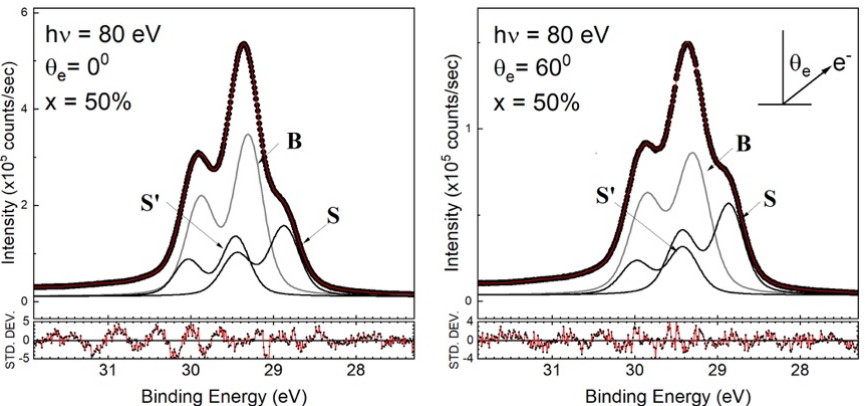
Figure 4. Fit to the Ge 3d core-level spectra with the 50% Ge content of Si 1 − x Ge x (001)-2 × 1. θ e is the emission angle with respect to the surface normal. Symbols S and S’ stand for Ge up-dimer and Ge down-dimer counterparts. Symbol B stands for the Ge bulk component.